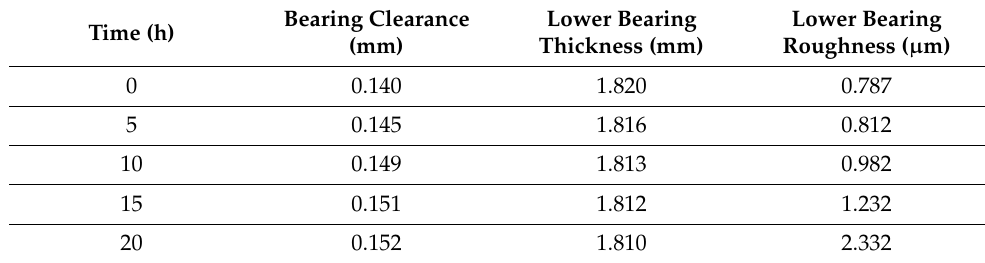
Table 3. Measurement results of the surface state of the copper alloy bearing at different times.